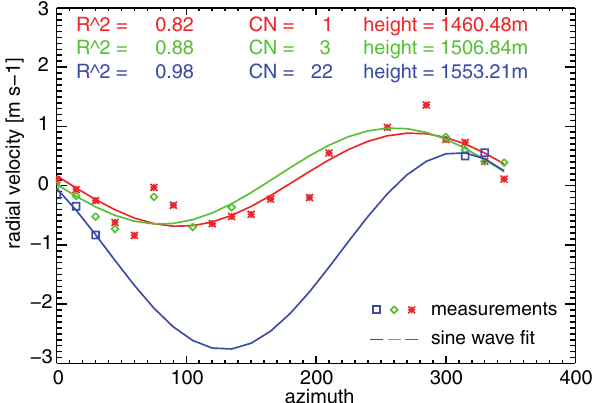
Figure 8. Overview of the data availability from 1-year measure- ments with Doppler lidar (DL), radar wind profiler (RWP) and radiosonde (RS). Data availability refers to 30min averaged pro- files for wind speed and direction. The number of data used for the DLWR comparison is a subset of data indicated by DL&RWP where both systems provide valid data at the same time. The graph denoted with DL&RS reflects a subset of data where the DL and RS provide valid data at the same time, which have been used for the DLRS